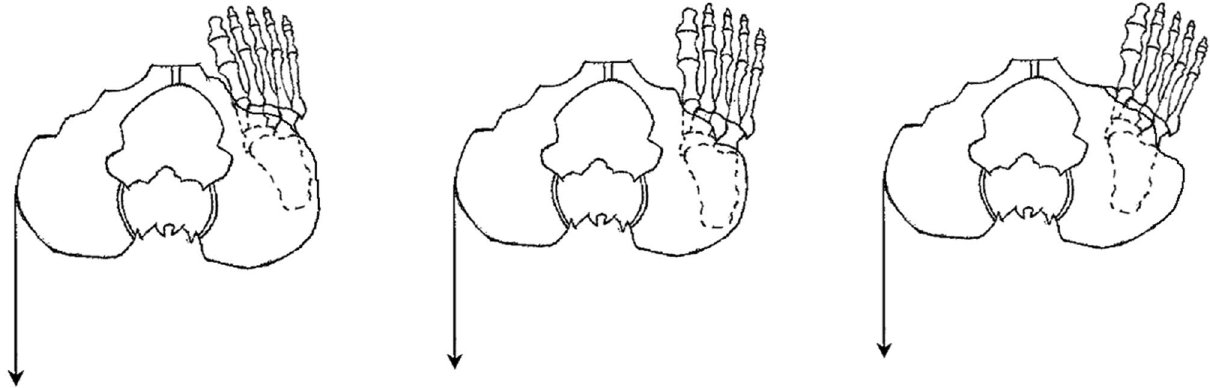
Figure 1. Superior-to-inferior view of performing PD in different positions of hip rotation by applying isometric force to the outer edge of the pelvic of the non-stance side (isometric hip external rotation of stance